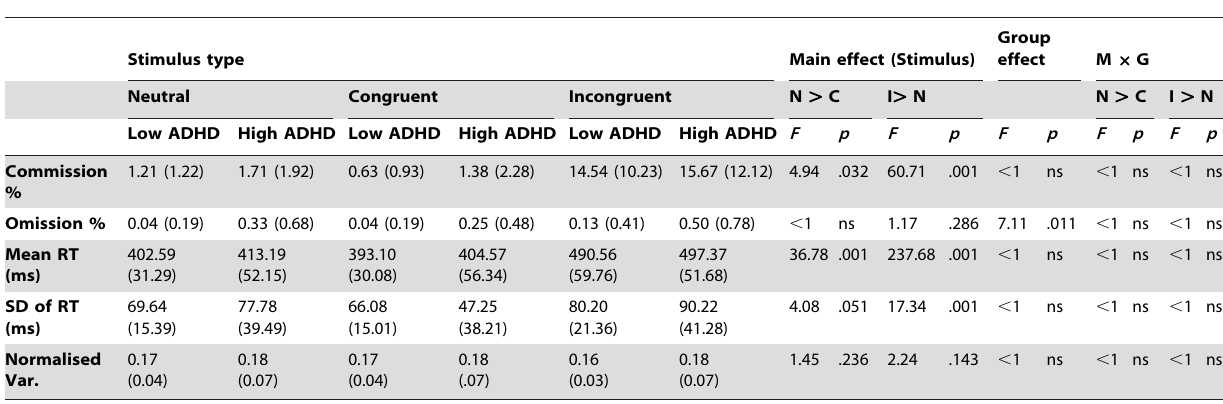
Table 1. Performance measures on the Eriksen